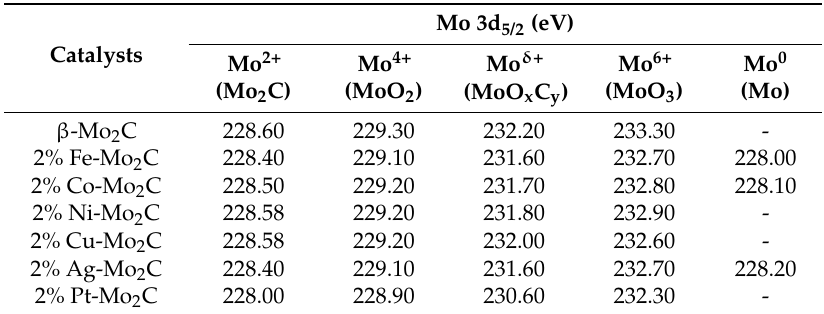
Table 1. Mo 3d 5/2 binding energy of 2% Fe-Mo 2 C, 2% Co-Mo 2 C, 2% Ni-Mo 2 C, 2% Cu-Mo 2 C, 2% Ag-Mo 2 C, 2% Pt-Mo 2 C and pure β -Mo 2 C catalyst.